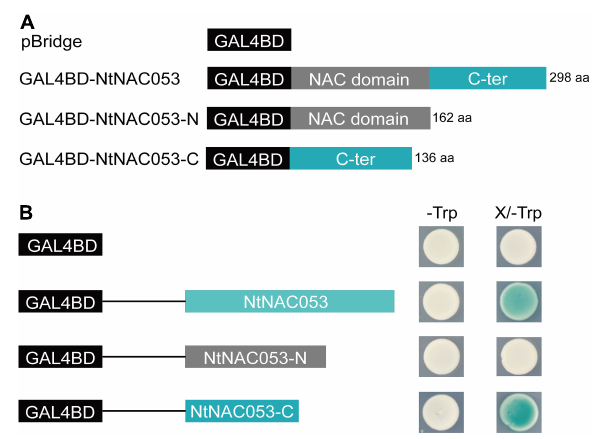
drought stress with no watering for approximately 10 days. The growth of overexpression lines and WT seedlings was almost the same under normal growth conditions. After the drought treatment, overexpression lines and WT seedlings displayed leaf wilting phenotype, whereas WT seedlings were much more extreme than that in overexpression lines ( Figure 7A ). After 3 days of re-watering, the survival rates of the OE6 lines